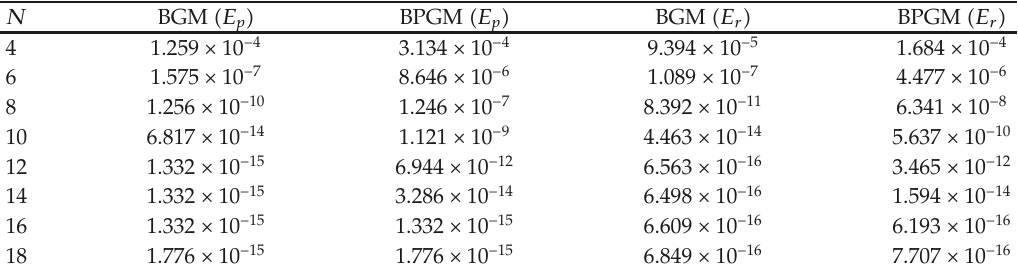
Table 2: (cid:7) E p (cid:8) and (cid:7) E r (cid:8) for N (cid:6) 4 , 6 ,... , 18.